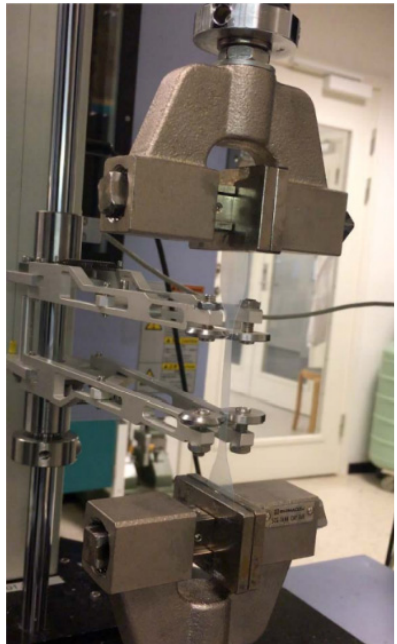
Figure 2. Sample mounted in the tensile testing